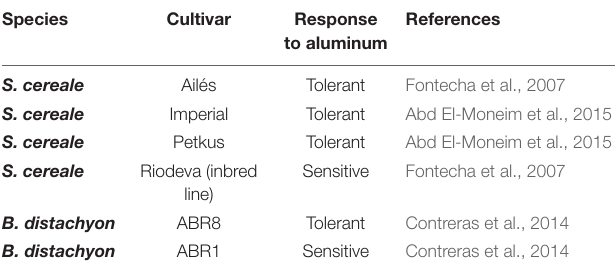
TABLE 1 | Names of the studied rye and Brachypodium cultivars and their response to aluminum